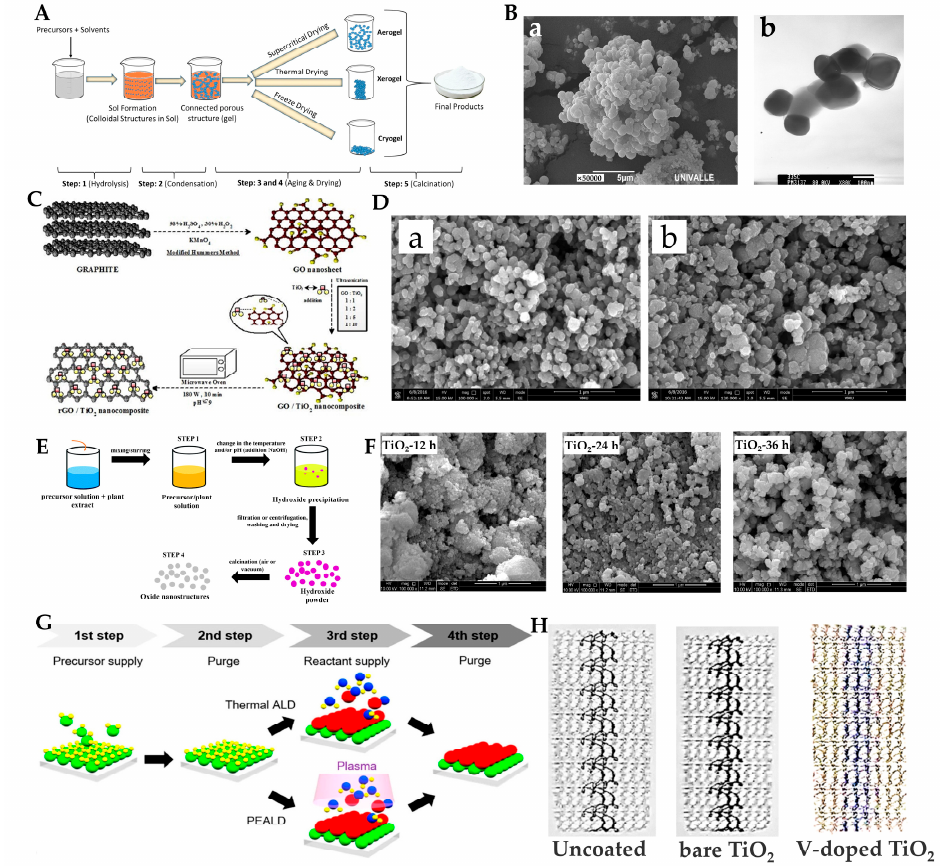
Figure 2. ( A ) Steps involved in the sol–gel process to synthesize MONPs [20]; ( B ) scanning electron microscopy (SEM) ( a ) and transmission- electron microscopy (TEM) ( b ) images of antimicrobials synthesized by the sol–gel method and thermally treated at 350 ◦ C for 2 h [25]; ( C ) illustration of rGO/TiO 2 nanocomposite formation [30]; ( D ) SEM images of TiO 2 -Sm ( a ) and TiO 2 -Ag ( b ) [31,32]; ( E ) schematic diagram showing all steps involved in a generic green synthesis mediated by plant extract using the coprecipitation method [35]; ( F ) SEM images of different TiO 2 samples [39]; ( G ) illustration of ALD [47]; ( H ) different PP mesh samples [44].